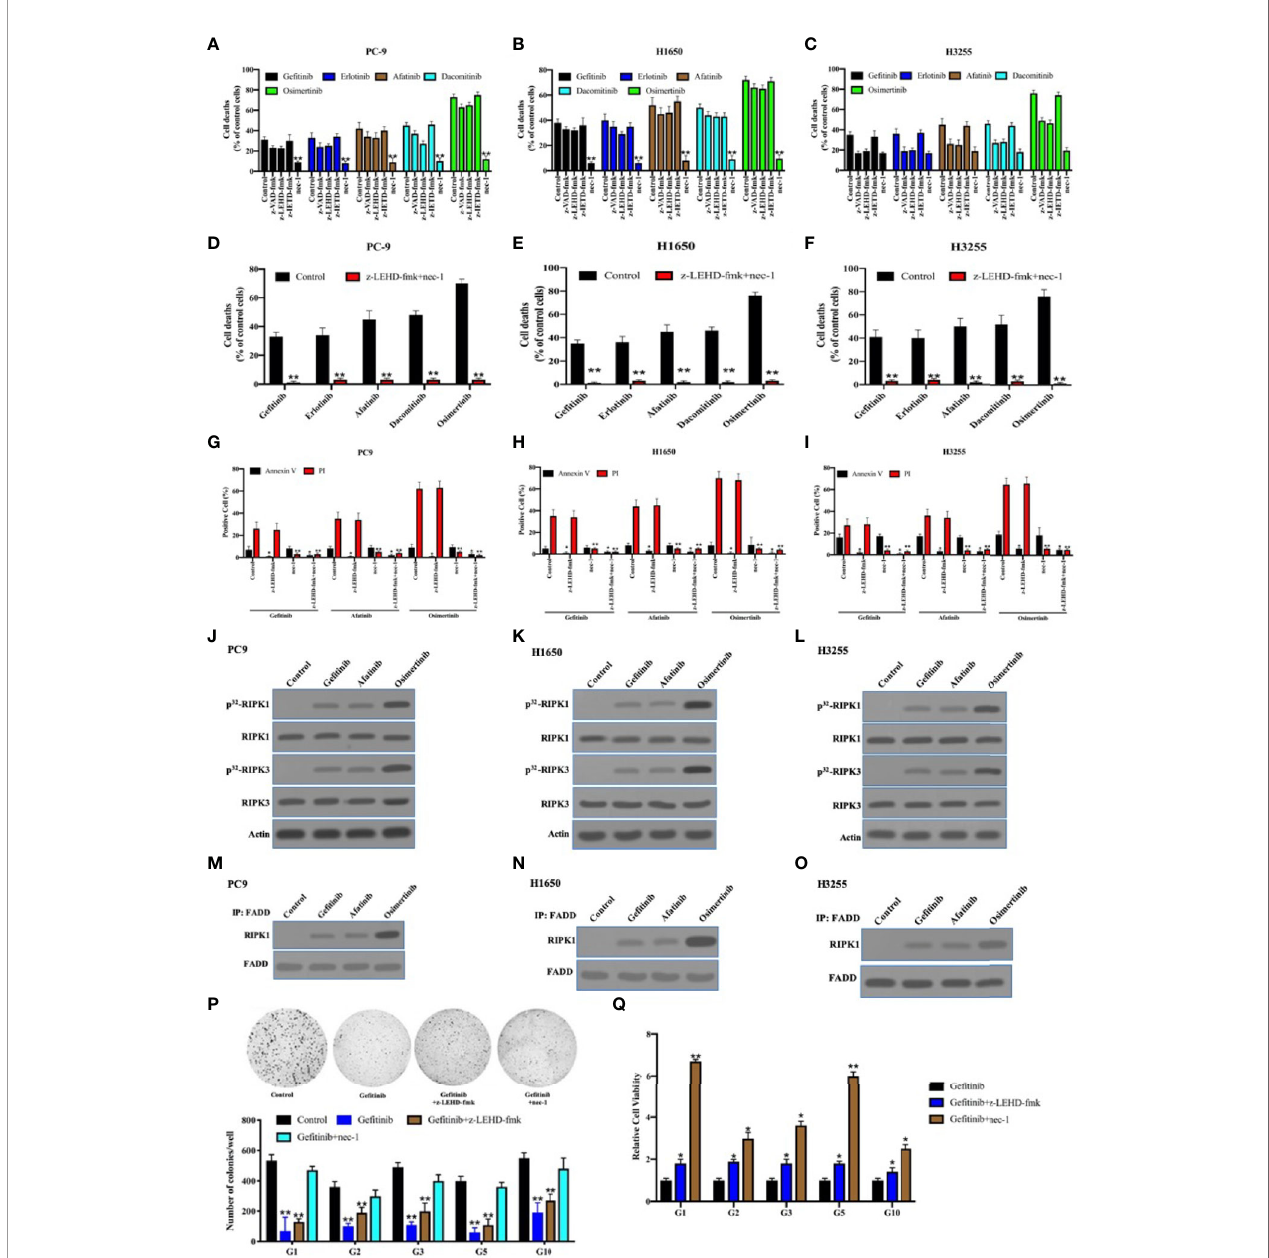
FIGURE 6 | The necroptosis through FADD complex was predominant for TKIs-induced cell death in the EGFR-mutant lung adenocarcinoma. (A – C) , PC9, H1650, and H3255 cells were treated with TKIs with the addition of DMSO (Control), zIETD-fmk, zVAD-fmk, and nec-1 for 48 h. Cell viability was determined by measuring ATP levels using Cell Titer-Glo kit. Data were represented as mean ± standard deviation of duplicates. **, p < 0.01. (D – F) PC9, H1650, and H3255 cells were treated with TKIs with the addition of DMSO (Control) and zIETD-fmk+nec-1 for 48 h. Cell viability was determined by measuring ATP levels using Cell Titer-Glo kit. Data were represented as mean ± standard deviation of duplicates. ** vs. control, p < 0.01. (G – I), PC9, H1650, and H3255 cells were treated with TKIs with the addition of DMSO (Control), zIETD-fmk, nec-1 and zIETD-fmk+nec-1 for 48 h. Cells were analyzed for Annexin V/PI staining by fl ow cytometry. All experiments were repeated 3 times with similar results. **, vs. Control, p < 0.01. (J – L) , Immunoblotting analysis of RIPK1, RIPK3 and b -actin in PC9, H1650 and H3255 cells treated with TKIs 48 h. Cells were labelled with [ 32 P]-orthophosphate. Phosphorylated RIPK1 and RIPK3 were measured by Cyclone Plus Phosphor Imager. (M – O) The immunocomplexes of PC9, H1650 and H3255 cells treated with TKIs for 48 h were eluted with antibody against FADD, and whole elution was used to measure RIPK1. (P) Soft agar colony formation assay of patient-derived tumor cells with DMSO (Control), ge fi tinib, ge fi tinib+zIETD-fmk and ge fi tinib+nec-1 in 12-well dish (5×10 3 cells per well) for 1 weeks ( n = 3). Representative images ( upper ) and average number of colonies ( lower ) are shown. **, vs. Control, p < 0.01. (Q) PC9, H1650, and H3255 cells were treated with ge fi tinib, ge fi tinib+zIETD-fmk and ge fi tinib+nec-1 for 48 h. Cell viability was determined by measuring ATP levels using Cell Titer-Glo kit. Data were represented as mean ± standard deviation of duplicates. * vs. control, p < 0.05. ** vs. control, p <